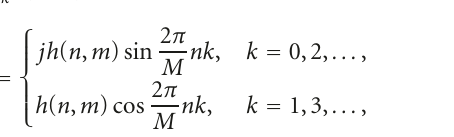
response function h ( n ) with roll-o ff factor r = 0 . 3 and r = 0 . 5,